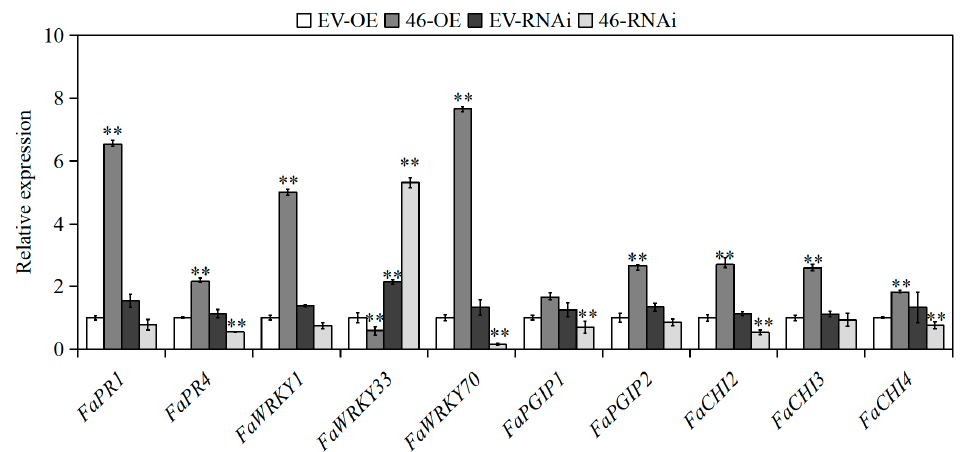
Figure 7. Effects of FabZIP46-OE and FabZIP46-RNAi on the transcription of resistance-related genes. EV-OE and EV-RNAi denote controls for the overexpressed or silenced fruits transformed with the corresponding empty vector. Values are means ± SD ( n ≥ 3). Asterisks above the columns denote significant difference at ** p < 0.05 levels according to the Student’s t -test.